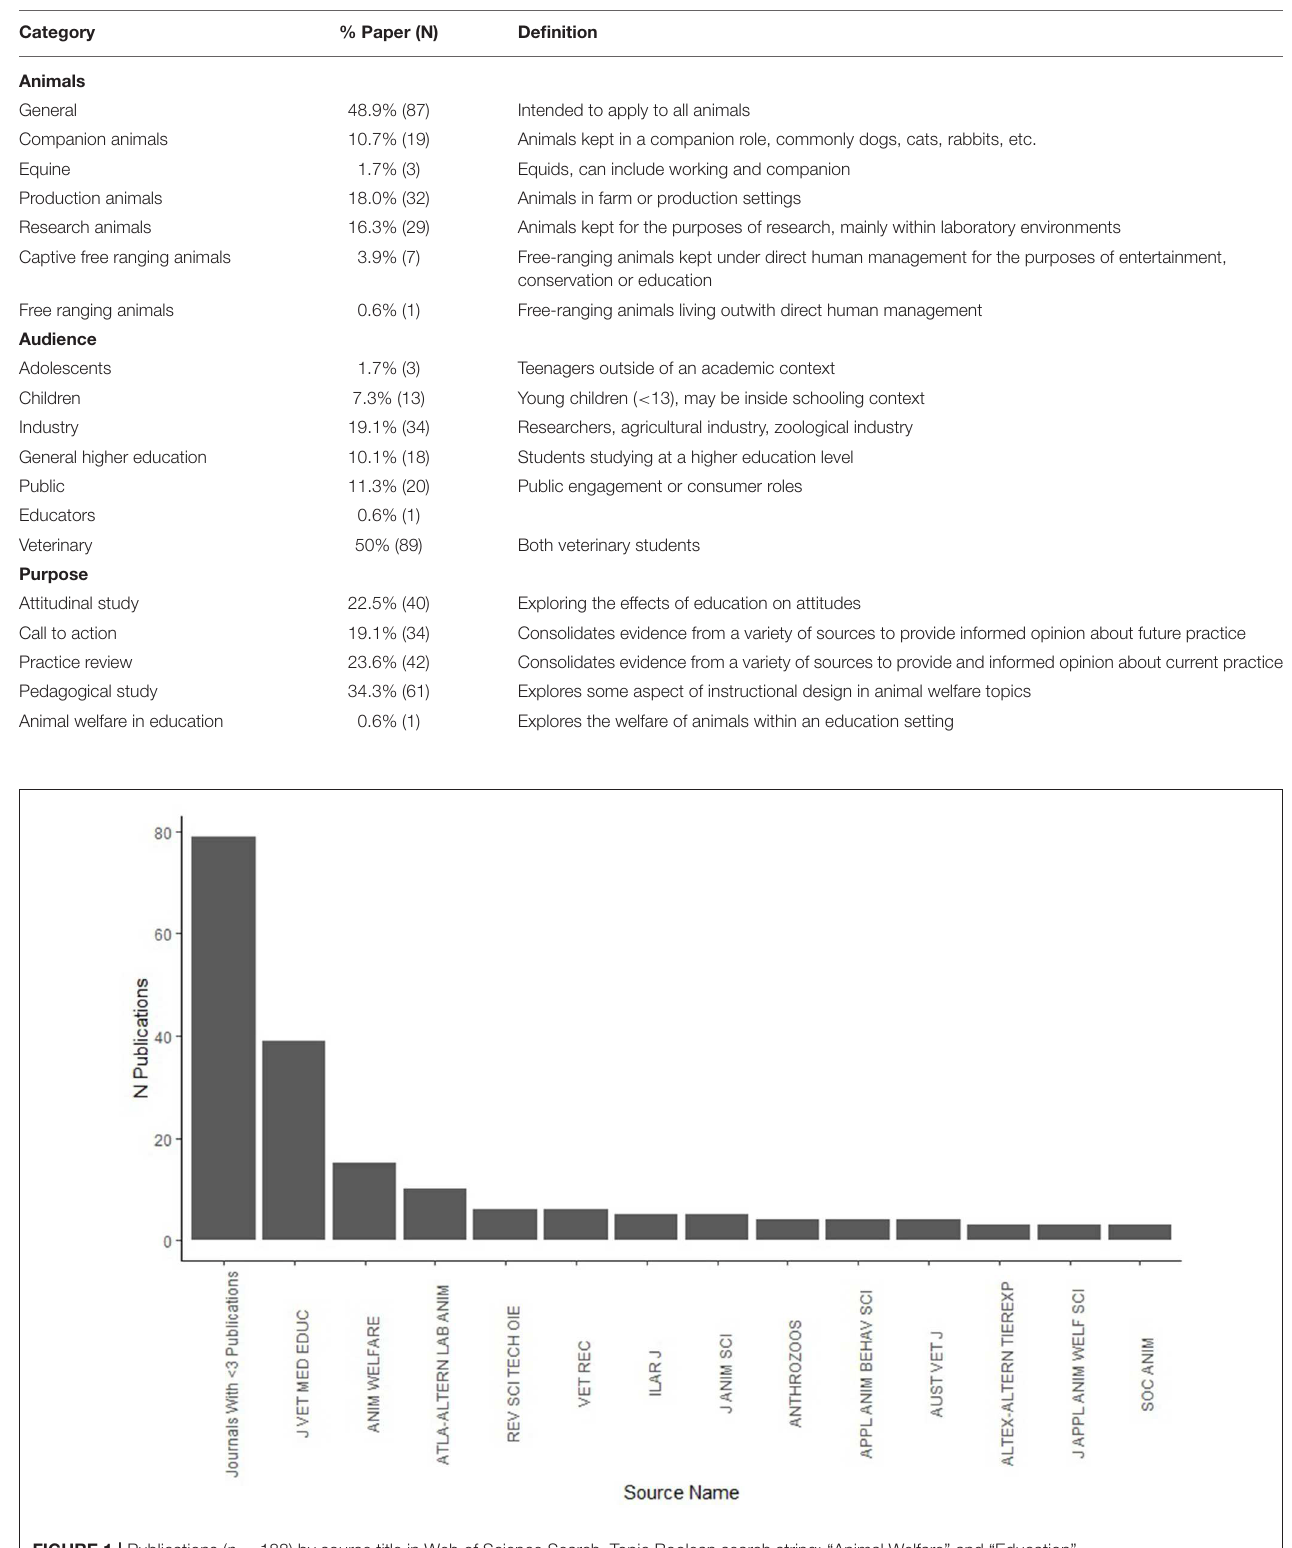
Frontiers in Veterinary Science |